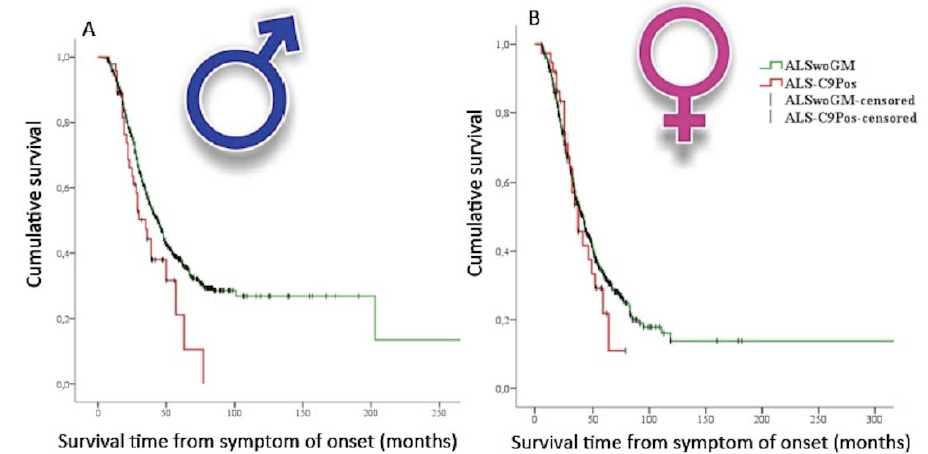
Figure 2. Kaplan–Meier plots of survival probabilities, stratifying the studied sample by sex [10]: shorter survival time is displayed in amyotrophic lateral sclerosis (ALS) patients carrying C9orf72 repeat expansion (ALS ‐ C9Pos) (red line) compared to ALS patients without documented genetic mutations (ALSwoGM) (green line) only for males. ( A) : (male): Log ‐ rank χ 2 = 4.33, p = 0.037; median survival was 35 months (95% CI. 26–44) for ALS ‐ C9Pos ( n = 47) and 44 months (95% CI. 40–48) for ALSwoGM ( n = 681). ( B ): (female): Log ‐ rank χ 2 = 0.43, p = 0.510; median survival was 37 months (95%